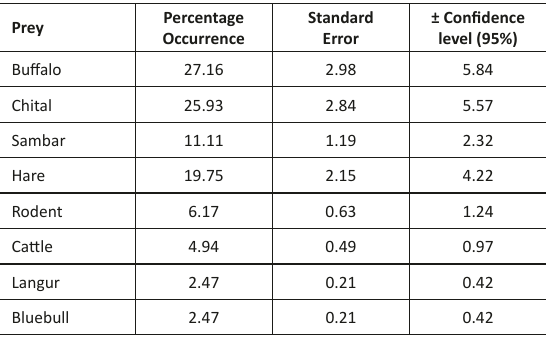
Table 2. Mammalian prey items detected in the diet of Golden Jackal in Gir National Park and Sanctuary, India. Prey